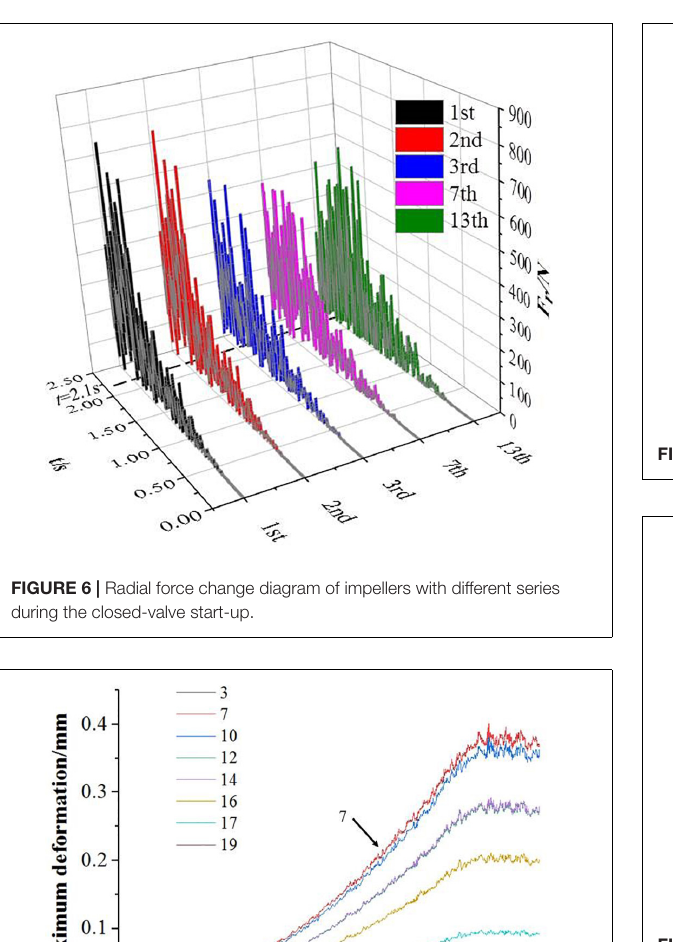
FIGURE 10 | Vibration velocity change diagram with time.